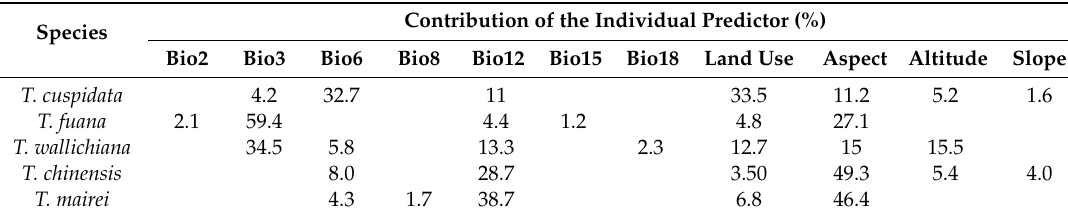
Table 3. Relative influence of individual variable on the distribution of each species.